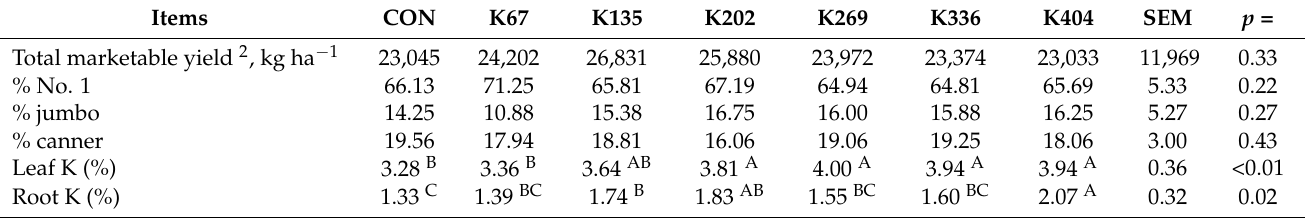
Table 2. Sweet potato yield parameters and tissue potassium (K) concentrations in response to K application rates from a field experiment conducted at the Pontotoc-Flatwoods Branch Experiment Station in Pontotoc, MS during the 2018–2021 growing seasons 1 .